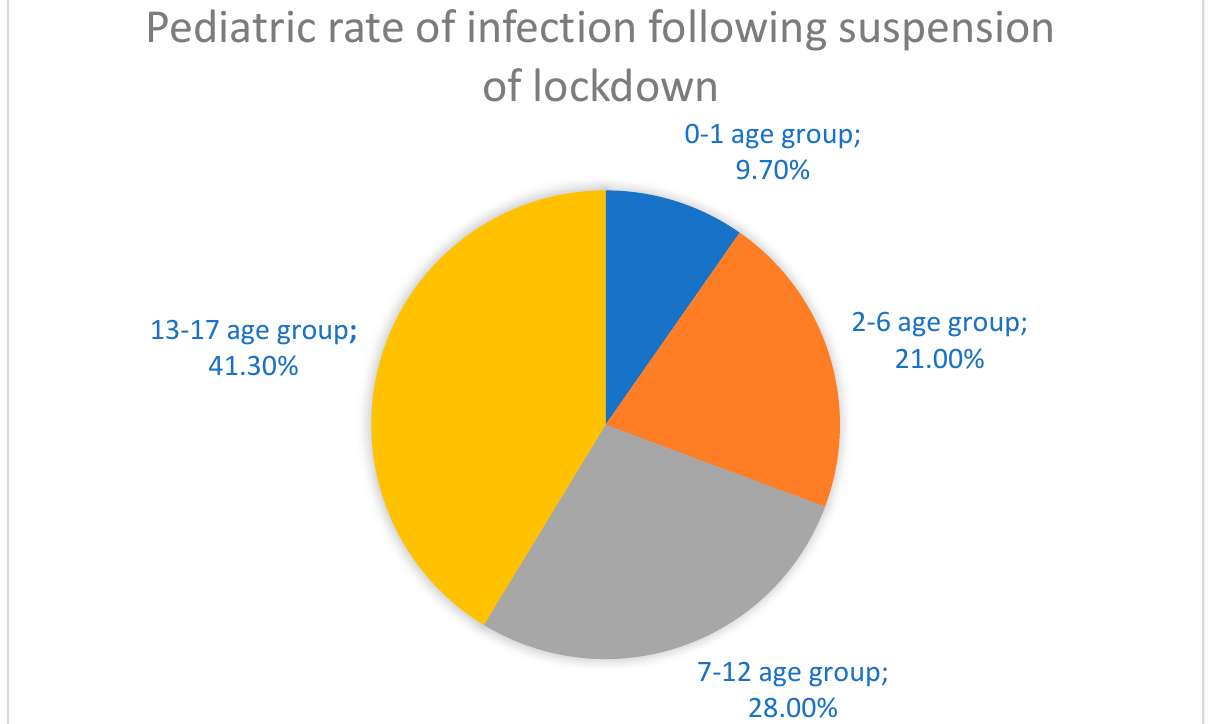
Figure 1. Rate of infection in the pediatric population after 4 May 2020.